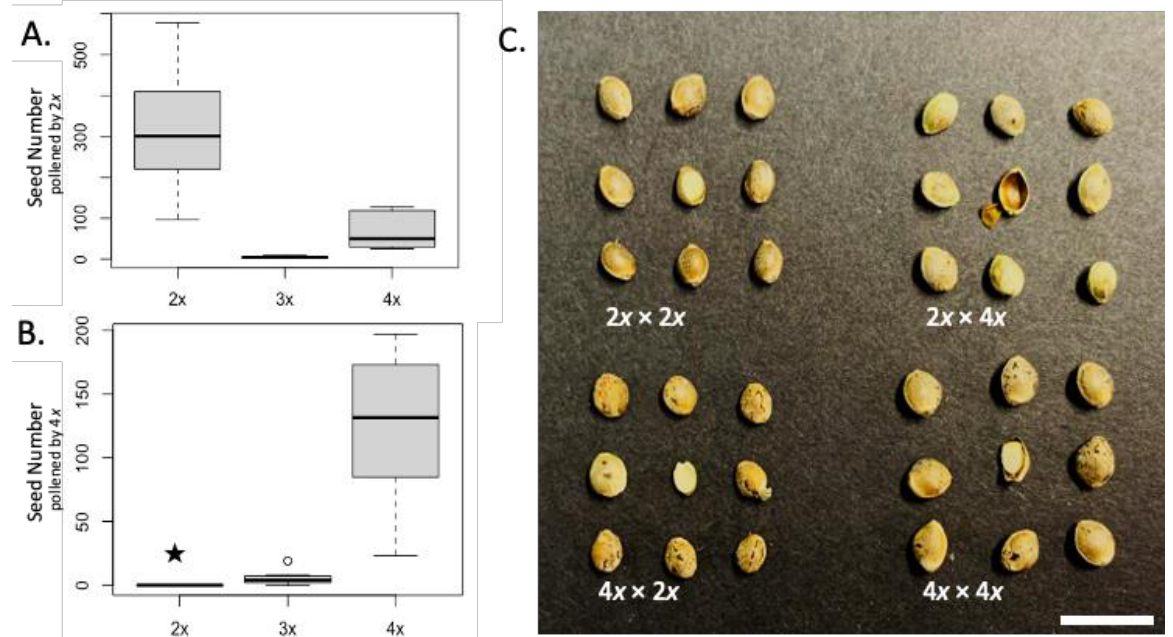
Figure 3. Results from interploidy crossing compatibility investigations of diploid, triploid, and tetraploid F 1 hybrid Cannabis sativa . ( A ) Average seed count of the three ploidies of F 1 hybrids, derived from crosses using diploid pollen donors and ( B ) tetraploid pollen donors. The star indicates that an average of 232.75 unfilled seeds and 0 filled seeds per plant were observed and the unfilled circle represents an observation outside of the 1.5 × inner quartile range cutoff as represented by the box and whiskers plots. ( C ) Seeds from several interploidy crossing combinations; one cut seed is displayed in the center of the grid to show seed development. Pericarps that developed as a result of the 2 x × 4 x crosses did not contain an embryo or endosperm. Bar = 1 cm. Table 2. Average seed number, seed weight, and crossing compatibility of intra- and inter-ploid hybridizations. Seed Parent